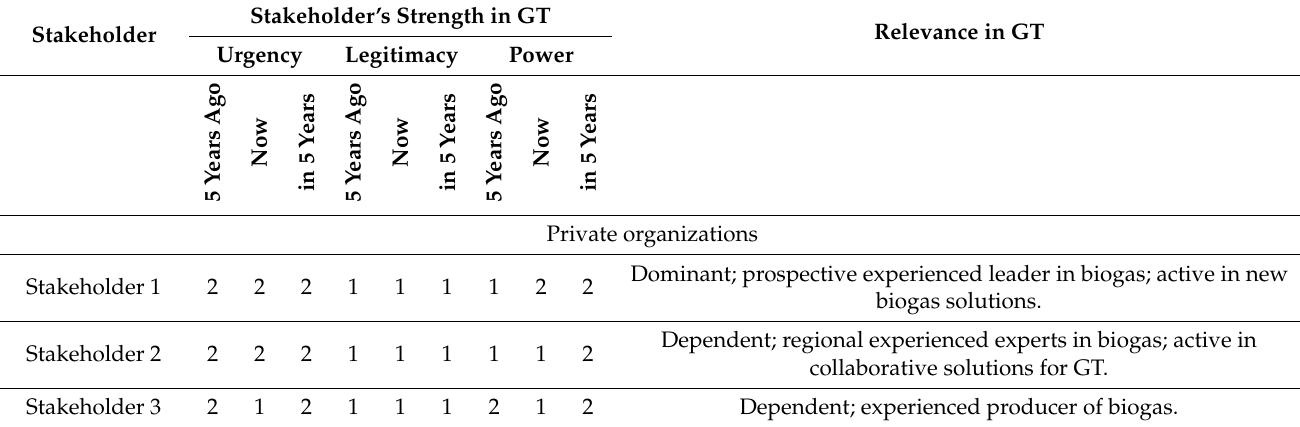
Table 3. Stakeholder’s power, urgency, and legitimacy for biogas production from manure and agro wastes in